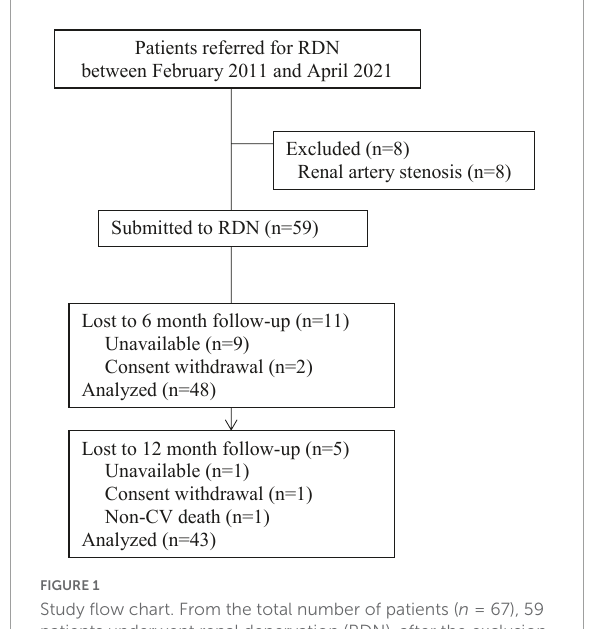
FIGURE1 Study flow chart. From the total number of patients ( n = 67), 59 patients underwent renal denervation (RDN), after the exclusion of eight patients due to renal artery